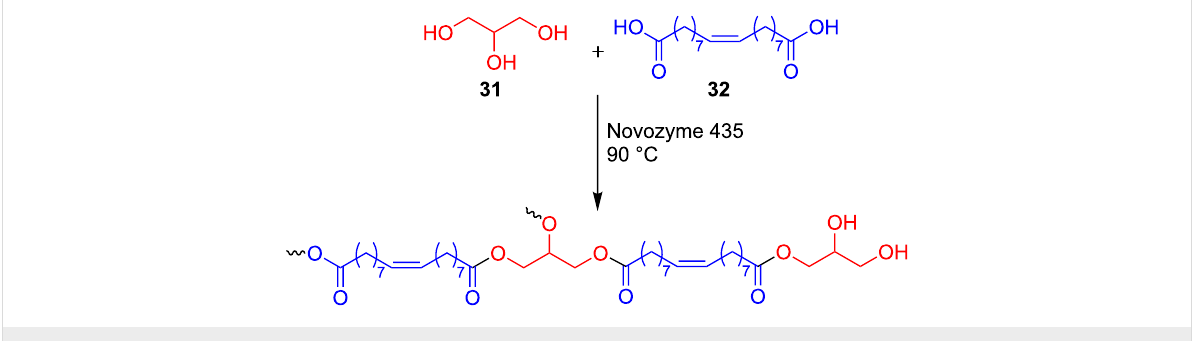
Symmetrical long-chain (C 18 , C 20 and C 26 ) unsaturated or epoxidized dicarboxylic acids were polycondensated with 1,3- propanediol or 1,4-butanediol using CAL-B [60]. At high temperature (70 °C) a number of polyester combinations could be synthesized. Propandiol afforded polymers with rather moderate molecular weights (2000–3000 Dalton), while with butandiol polyesters with higher molecular weights (8000–12000 Dalton) were obtained. Interestingly, the poly- mers carried functional groups in the chain that could be used for further modifications.